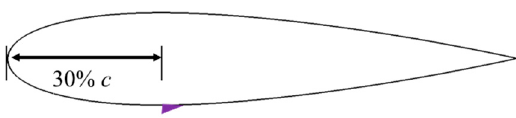
Figure 3. Position of the plasma actuator on a blade.